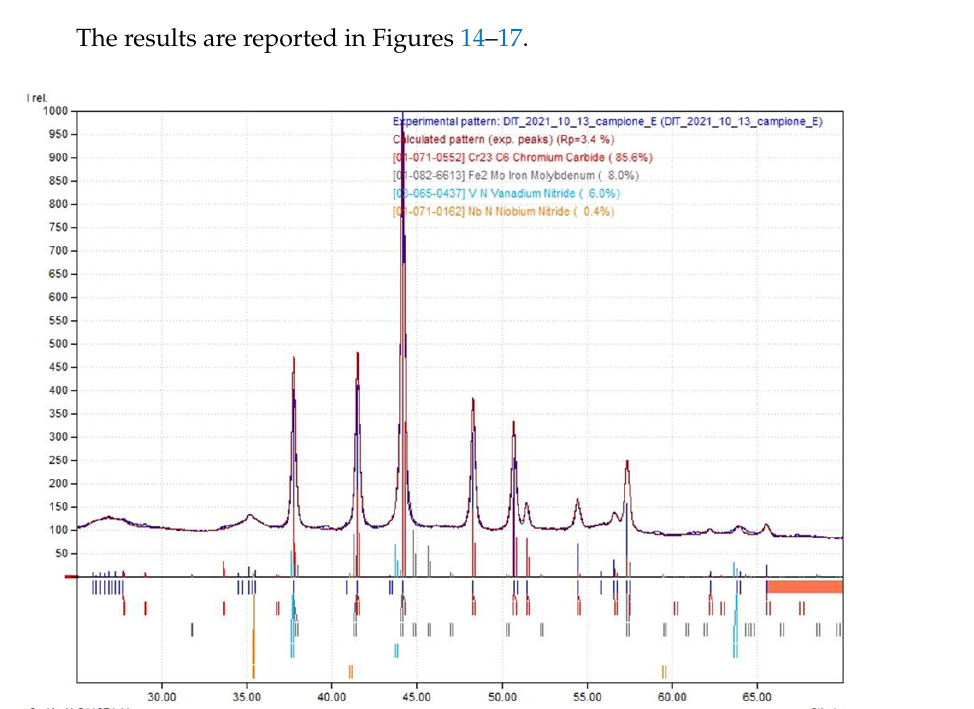
Figure 14. Exposed material specimen 92-EX-1-2 (92 BM 604 °C 43 MPa 74,001 h) (sample E), XRD analysis.